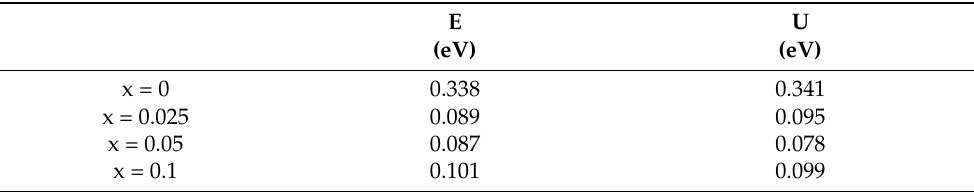
Table 3. Activation-energy values for conduction (E) and for relaxation process (U) for NSTO